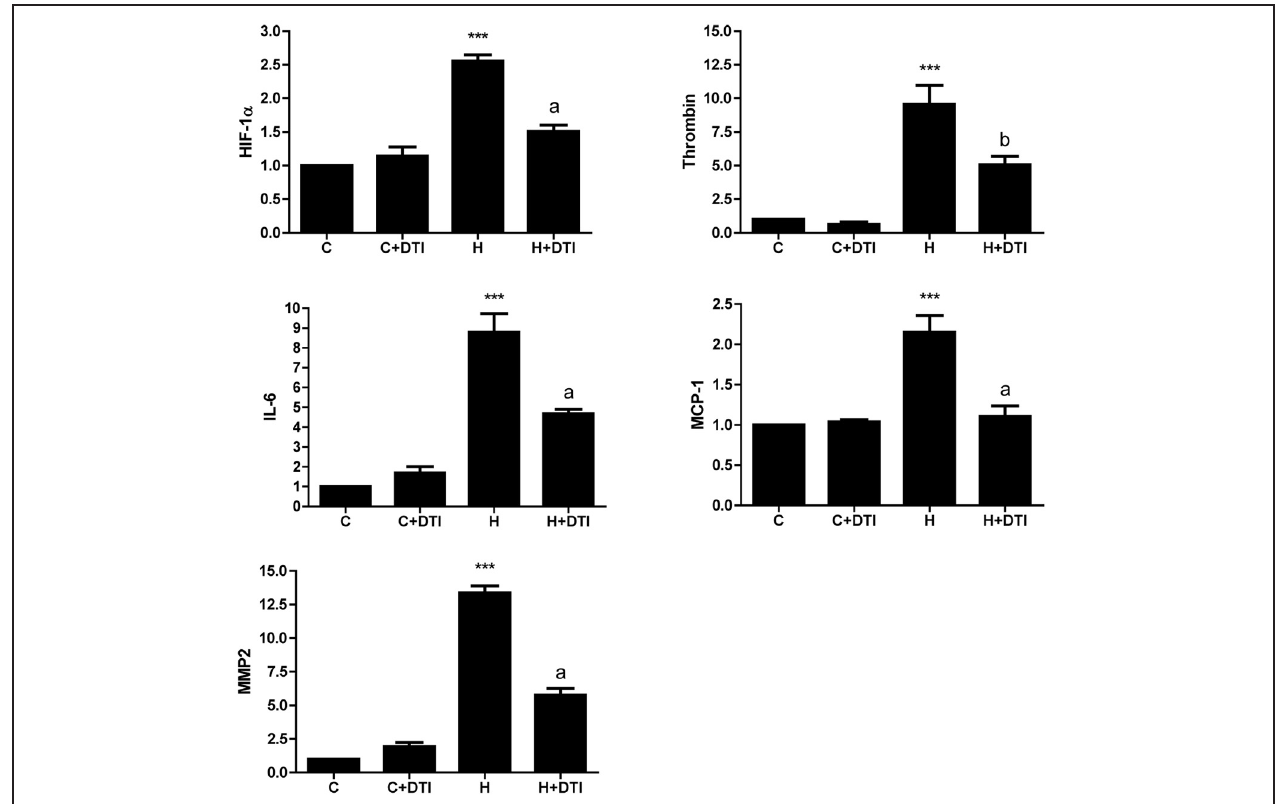
FIGURE 1 | Brain microvascular endothelial cell cultures were treated with 1nM direct thrombin inhibitor, dabigatran (DTI) and were exposed to hypoxia for 6h. Total RNA was collected, reverse transcribed, and mRNA expression of HIF-1 α , thrombin, IL-6, MCP-1,